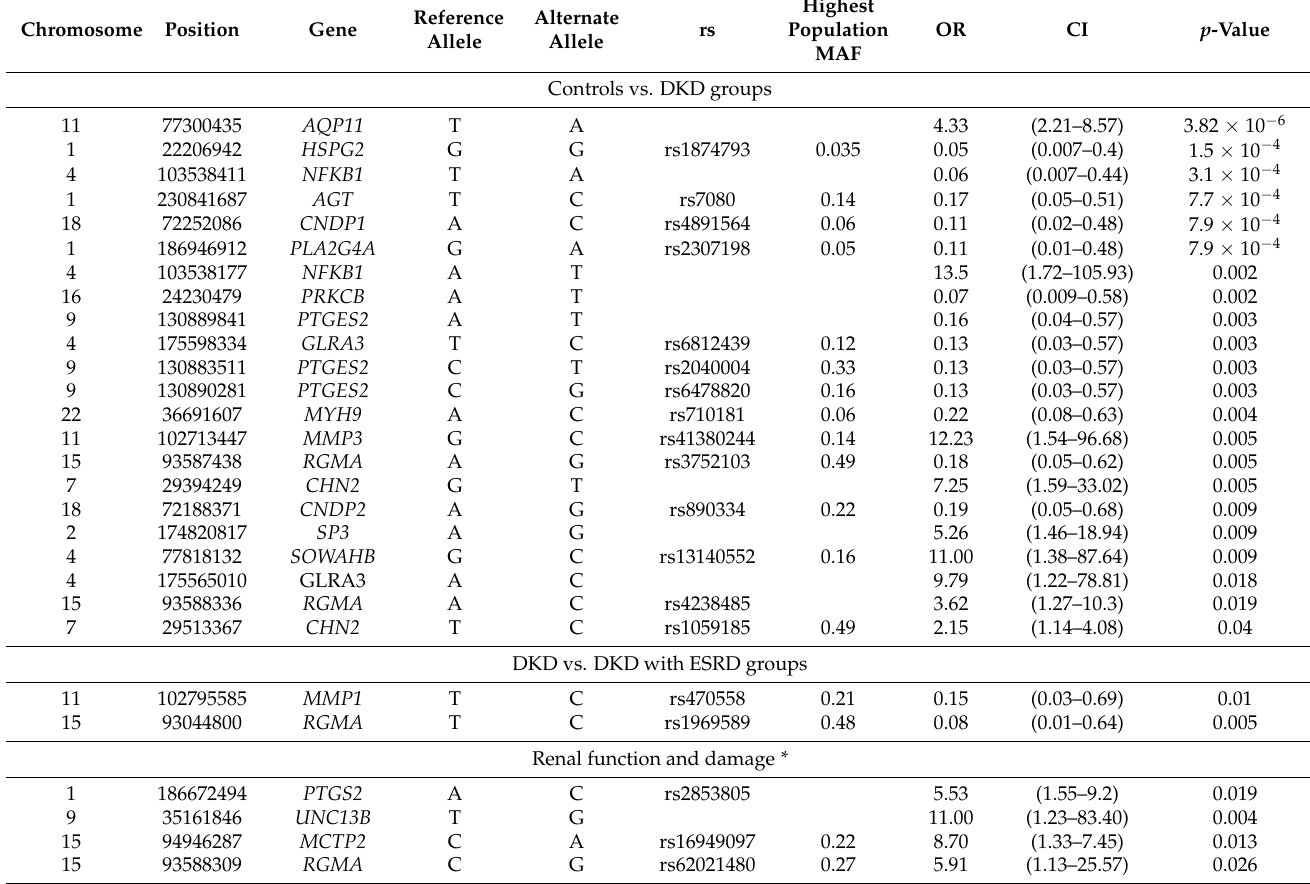
Table 2. List of gene variants found to be relevant in the discovery cohort and that were subsequently tested in the replication cohort. Rs number is shown when